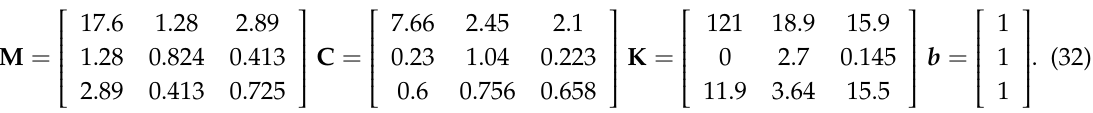
Figure 8. Maximum singular value: traditional PPP and the proposed method (test-case 2).